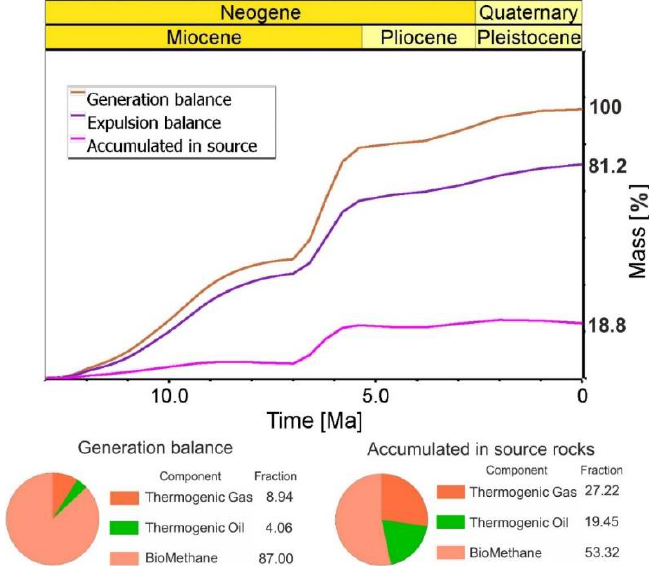
Figure 17. Progress of hydrocarbon generation, expulsion, and accumulation within fine-grained (Complex 3) complex (plot) and proportion between generated, expelled, and accumulated masses of hydrocarbons; below: Composition pie charts of generated ( left ) and accumulated ( right ) components evidencing the increasing share of thermogenic fraction in accumulations within mudstones–claystones.